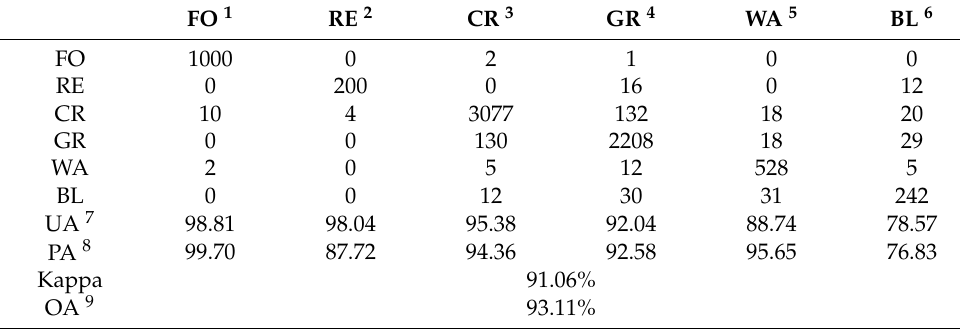
Table A3. Accuracy assessment results of LULC map used in SWAT